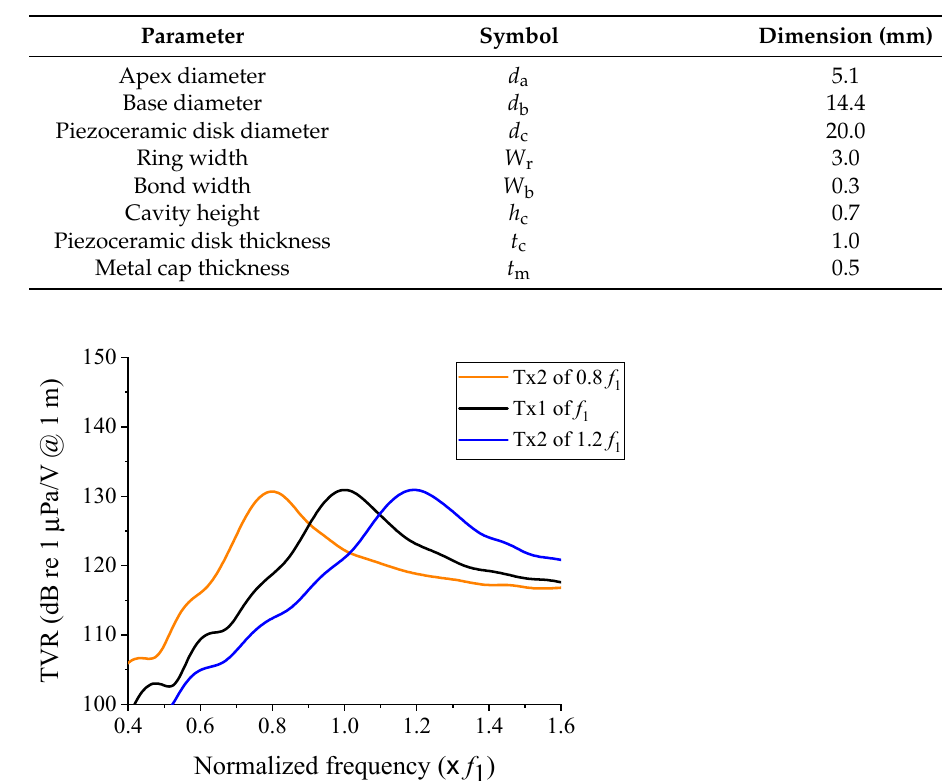
Table 1. Dimensions of the designed Tx 1 transducer.